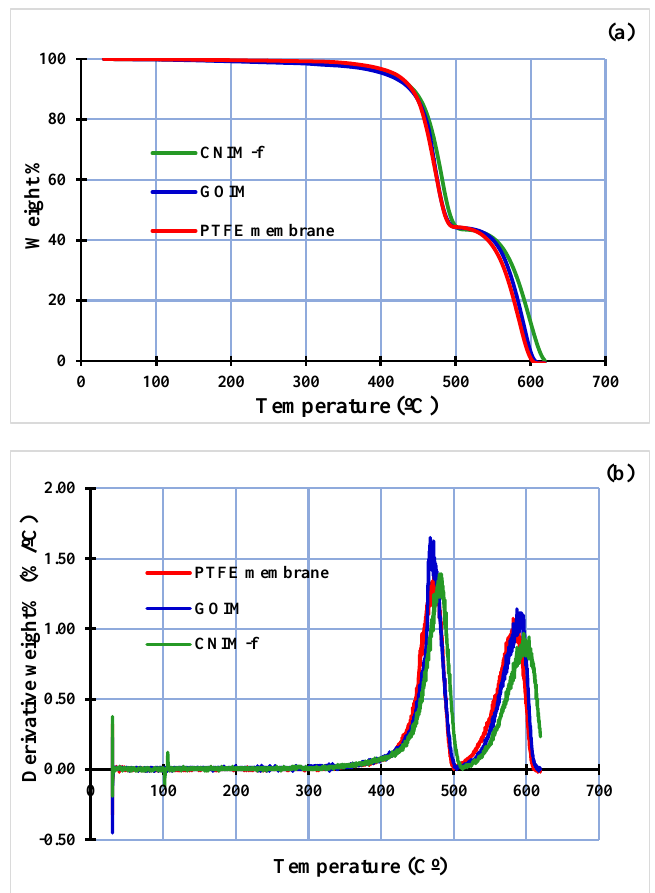
Figure 4. Thermogravimetric analysis (TGA) ( a ) and the derivative thermogravimetry ( b ) of the PTFE membrane, GOIM and CNIM-f.